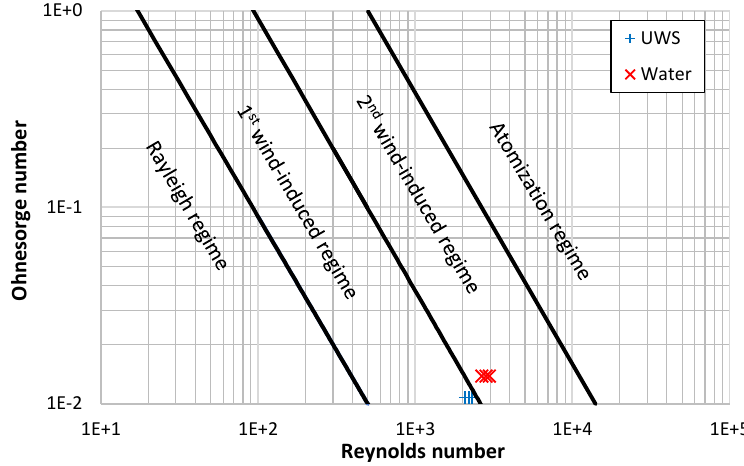
Figure 9. Jet break-up regimes and the considered injection cases (based on [31,32]).